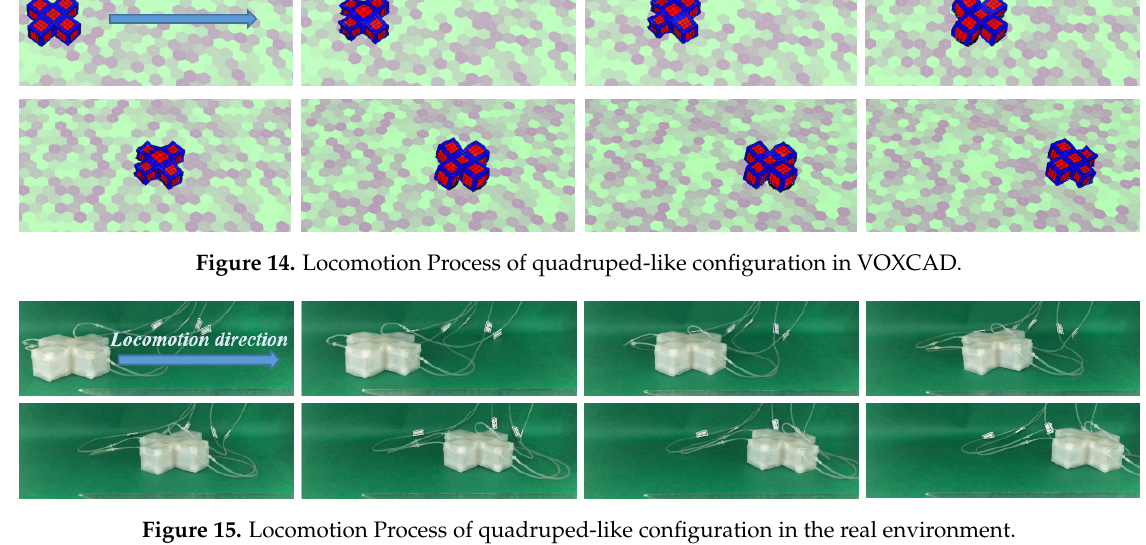
Figure 15. Locomotion Process of quadruped-like configuration in the real